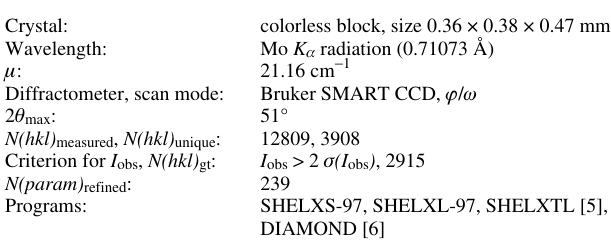
Table 1. Data collection and